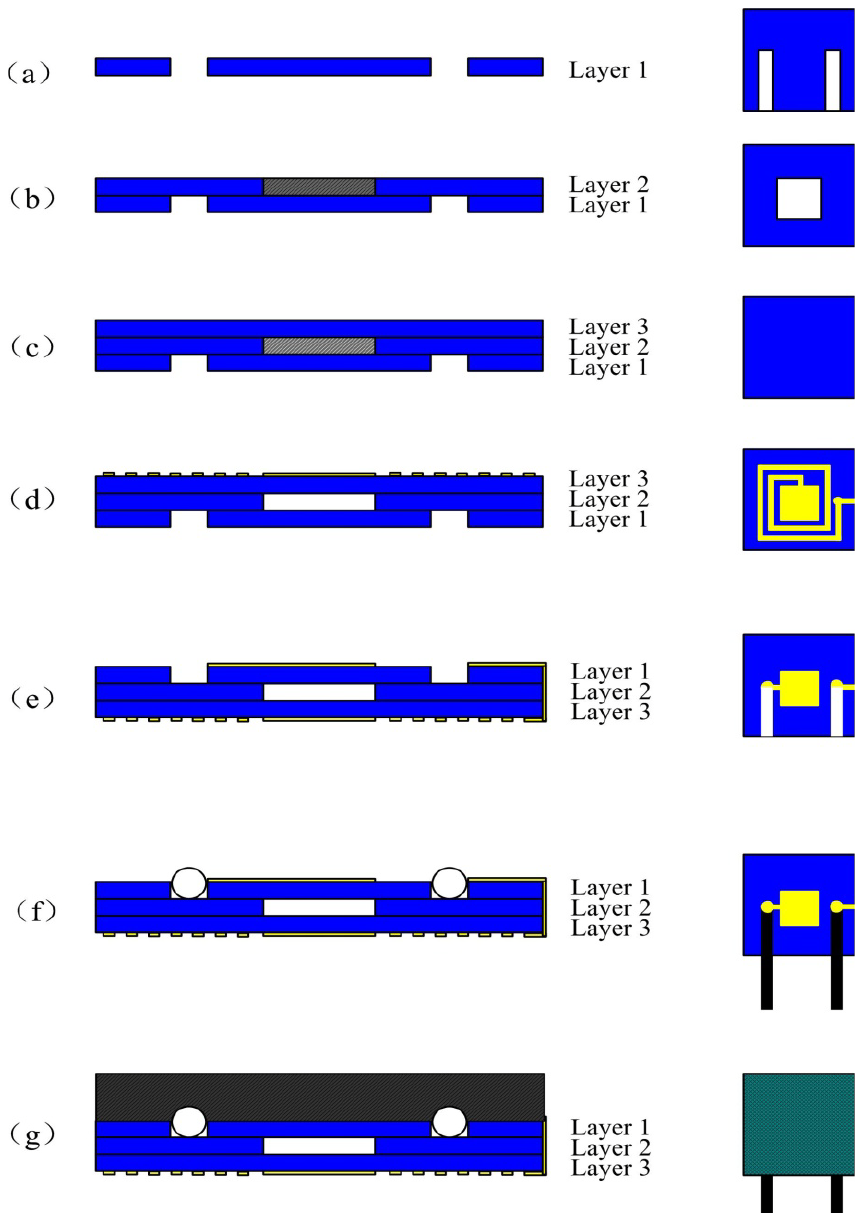
Figure 3. Fabrication process of the sensor.